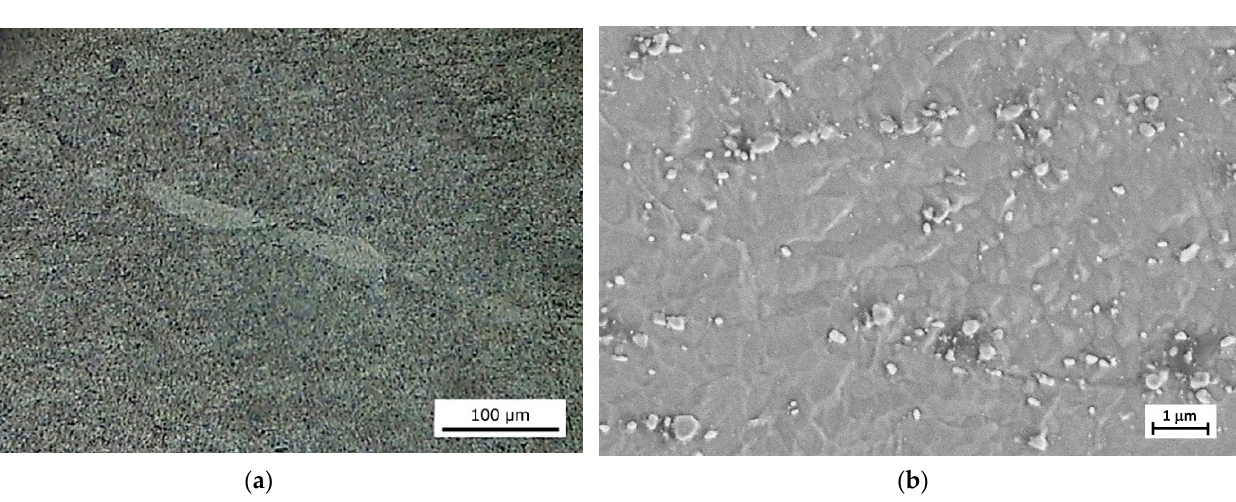
Figure 9. EUROFER97 deformed with a CR ratio of 80% and treated for 1 h at 750 °C. LM micrograph in ( a ) shows grains of abnormal size which are surrounded by quite smaller grains displayed by the SEM image in ( b ).